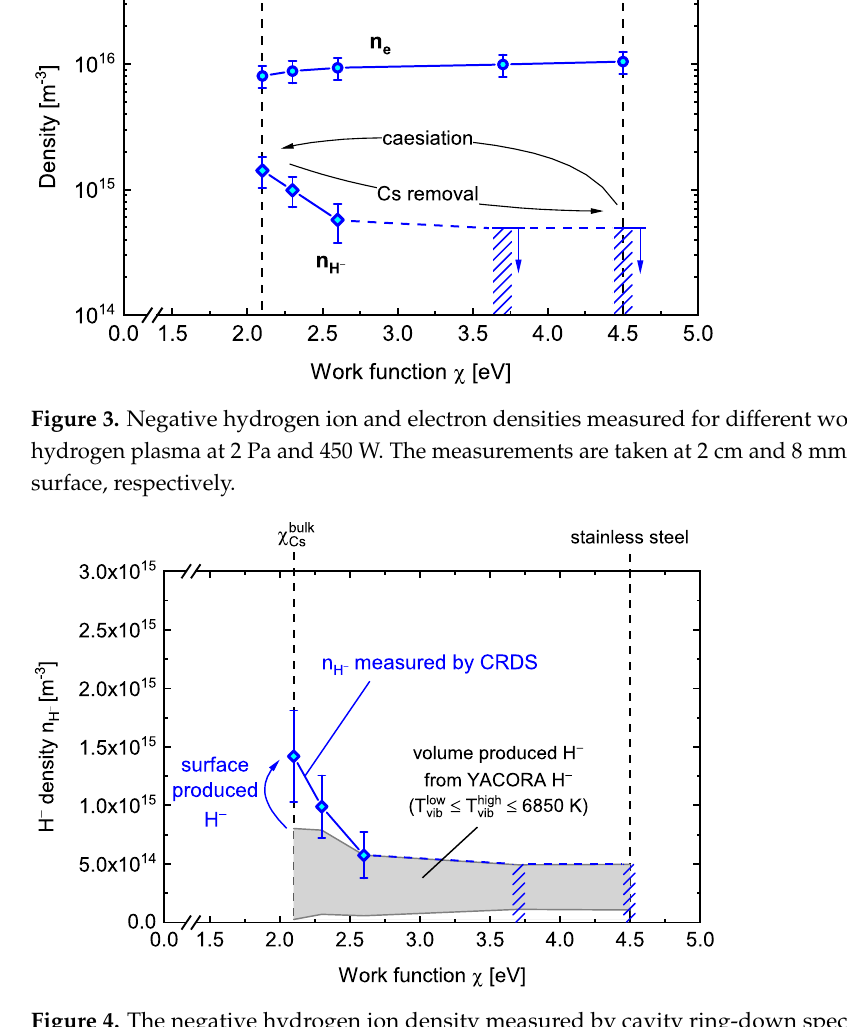
Figure 4. The negative hydrogen ion density measured by cavity ring-down spectroscopy system (CRDS) is shown for different work functions. The gray shaded area shows possible values for the density of negative ions created by volume processes and obtained from YACORA H −